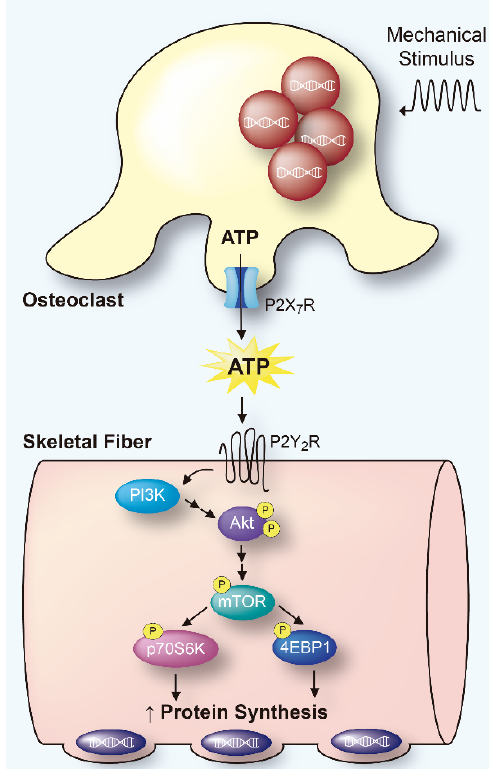
Figure 6. Graphic summary: ATP released by mechanically stimulated osteoclasts leads to protein synthesis in skeletal muscle through the Akt-mTOR signaling pathway. synthesis in skeletal muscle through the Akt-mTOR signaling